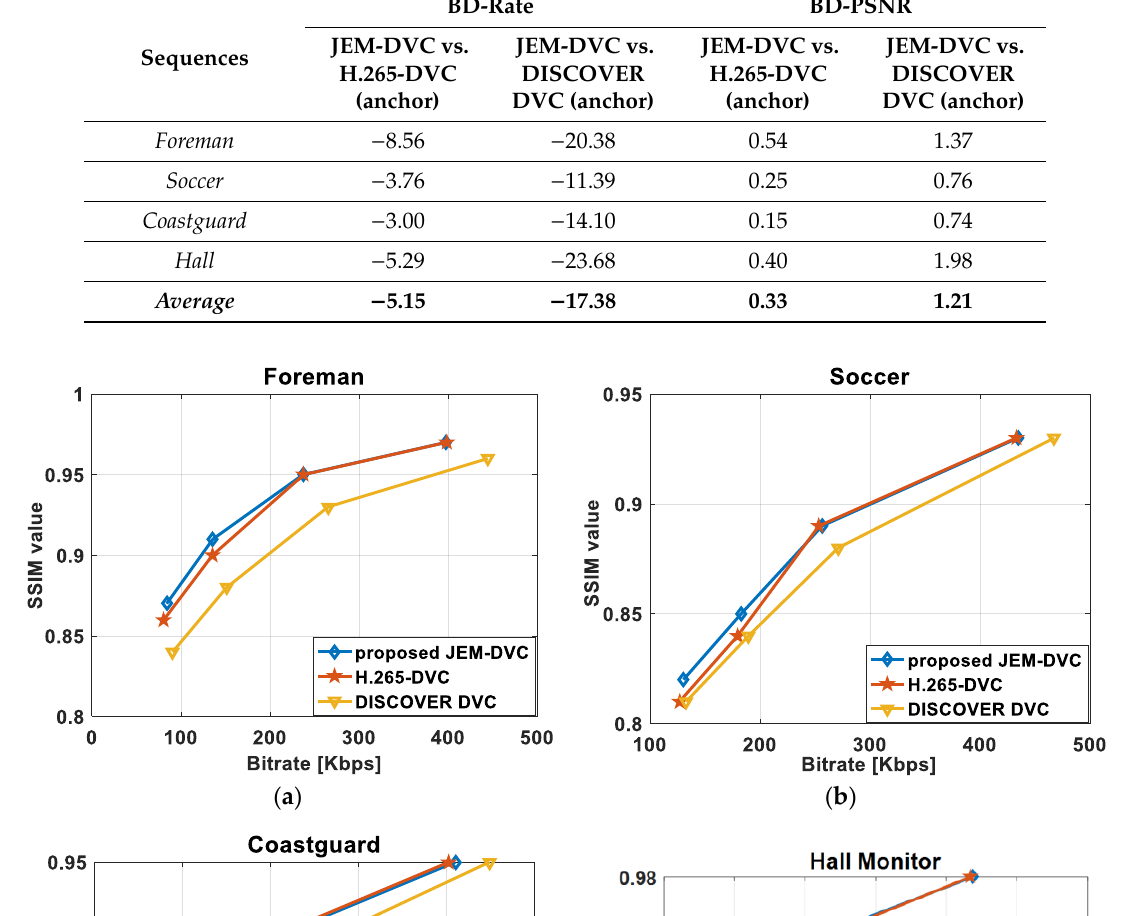
Table 2. Comparisons of BD-Rate and BD-PSNR [29] between the proposed JEM-DVC with H.265-DVC and DISCOVER DVC.